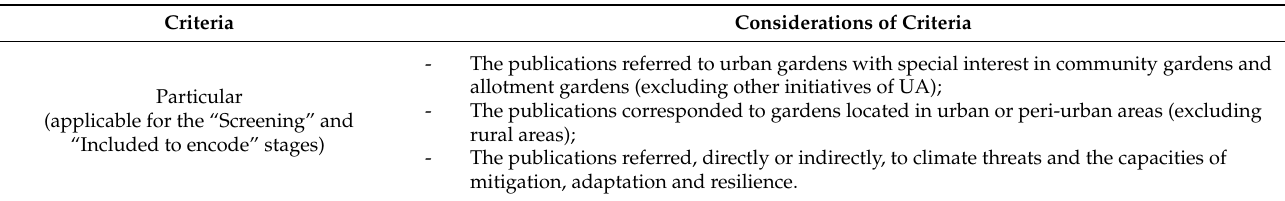
Table 1. Cont. Criteria Considerations of Criteria Particular (applicable for the “Screening”